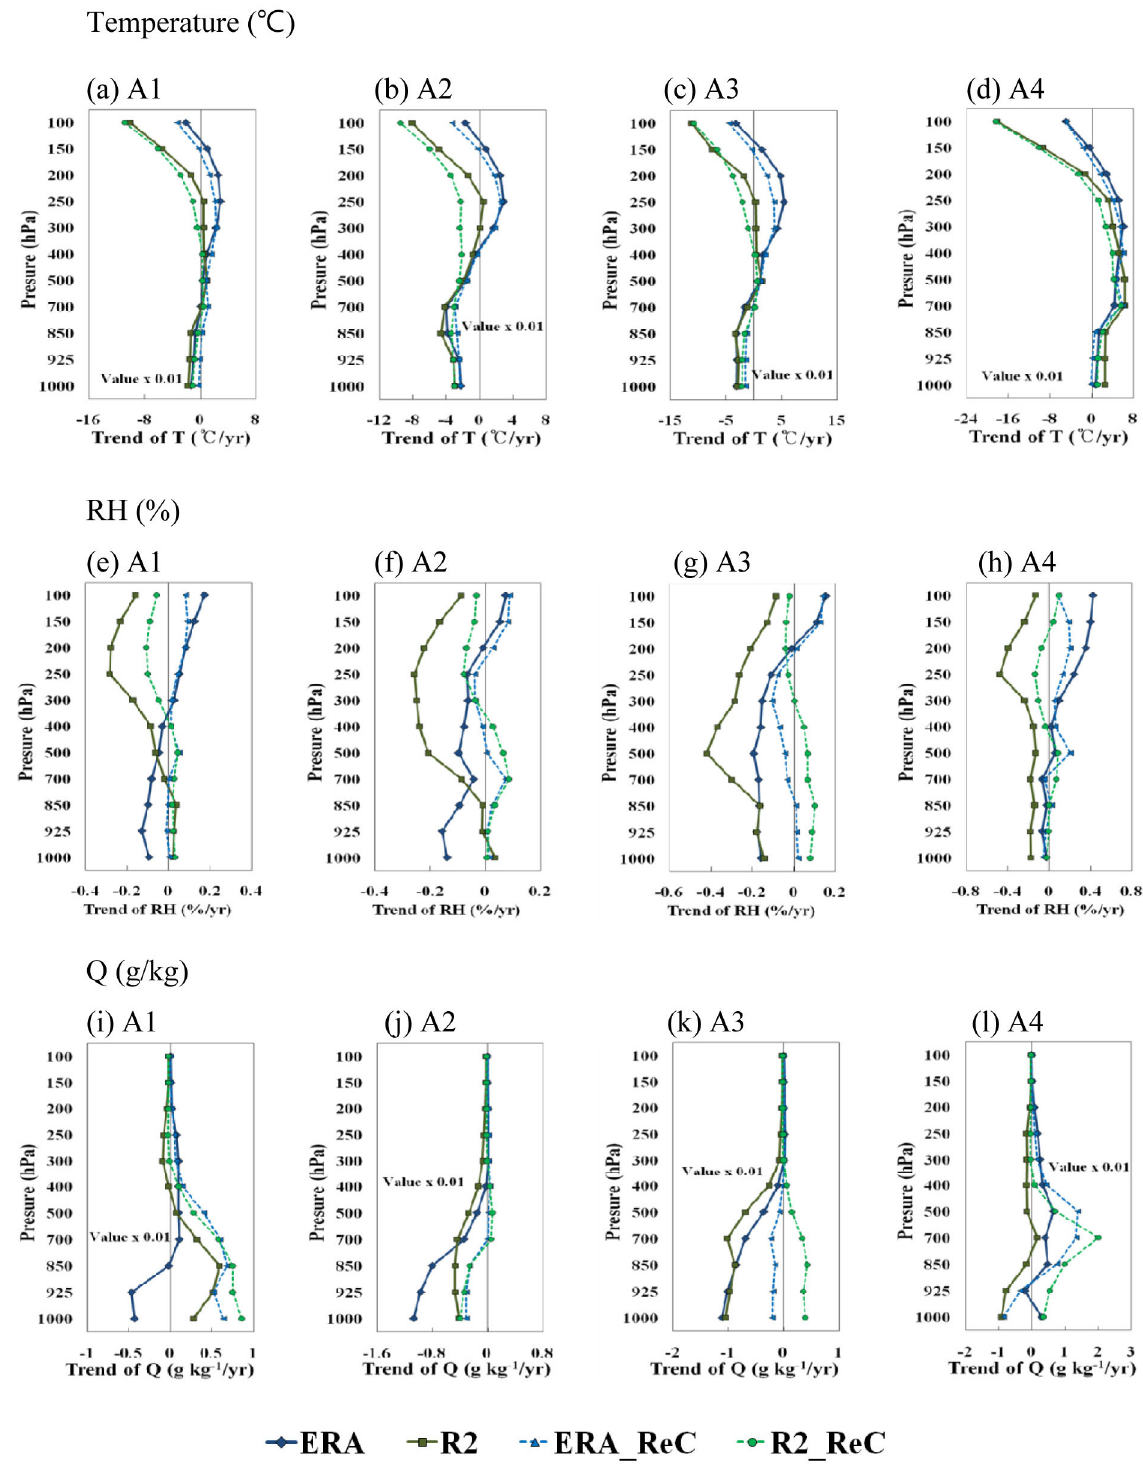
Figure 10. Vertical profiles of 20-year winter averaged trends for the ERA and R2 datasets, and simulations of RegCM4 forced by ERA and R2 data, over the selected sub-areas (Figure 1) for three selected climate elements (temperature ( a – d ), RH ( e – h ) and Q ( i – l